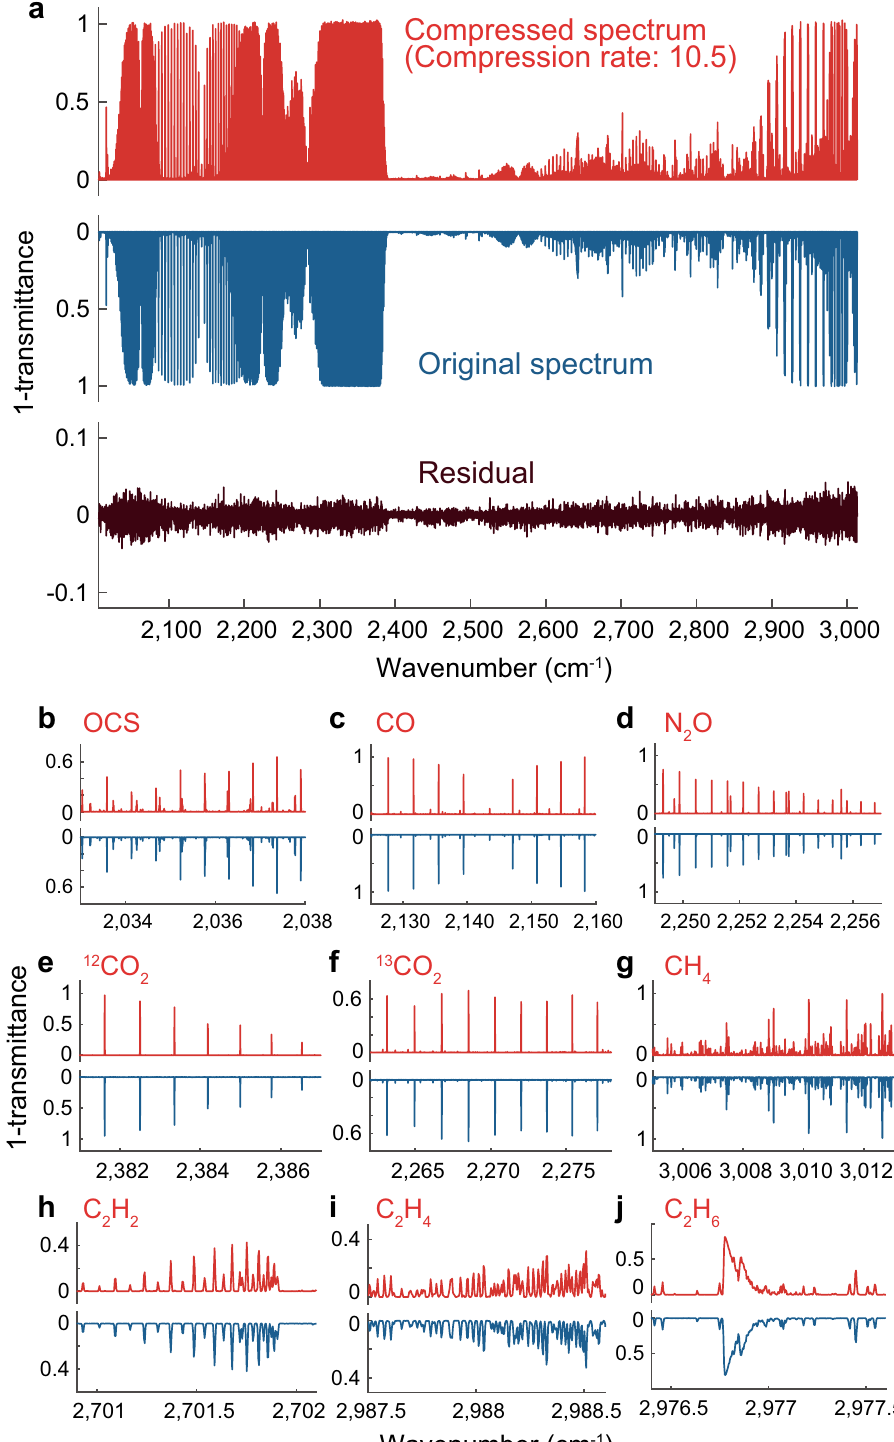
Figure 5. Massively parallel spectra of 10 trace gas species. ( a ) Comparison between a compressed spectrum and an original spectrum. The compressed spectrum is reconstructed from 50,000 points (compression rate of 10.5). ( b – j ) Zoom-in spectra of characteristic absorption lines of different molecular